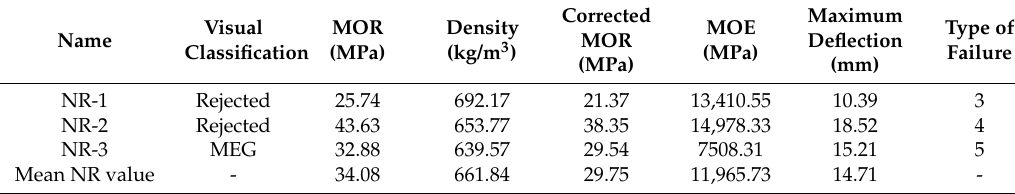
Table 2. Mechanical results obtained from bending tests of non-reinforced beams (NR). Visual classification, MOR (maximum bending capacity), density, density-corrected MOR, MOE (bending elastic modulus), maximum deflection and type of failure (according to classification of Figure 4).